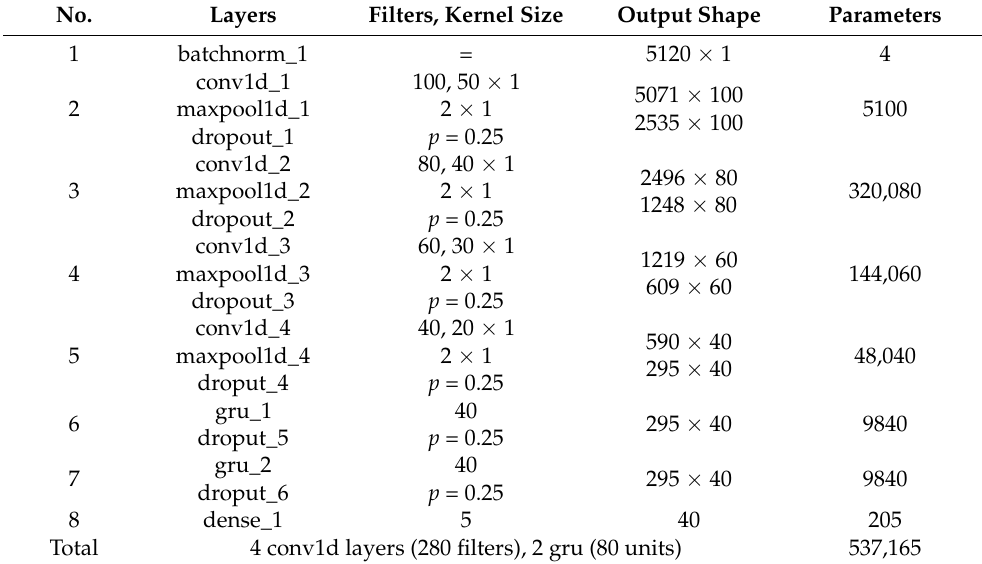
Table 3. Detailed structure of the proposed SDN